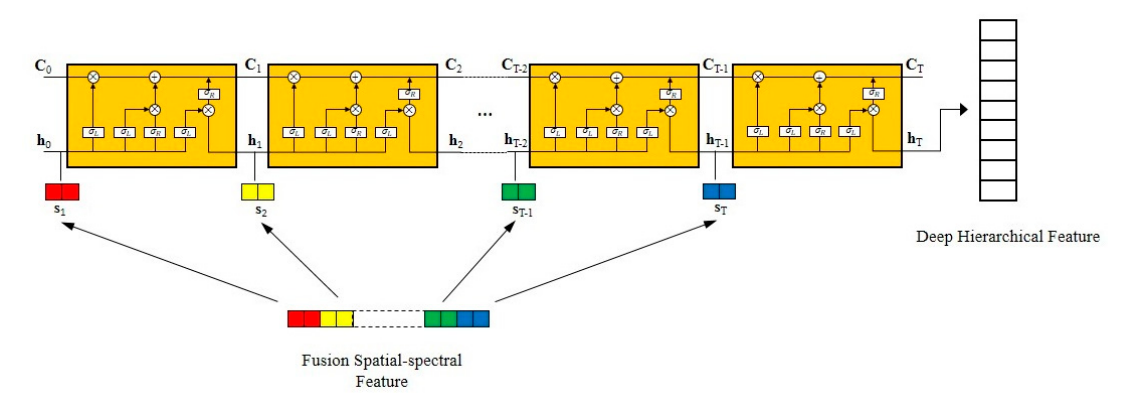
Figure 5. Hierarchical spatial-spectral feature from the fusion feature with the LSTM-based model.